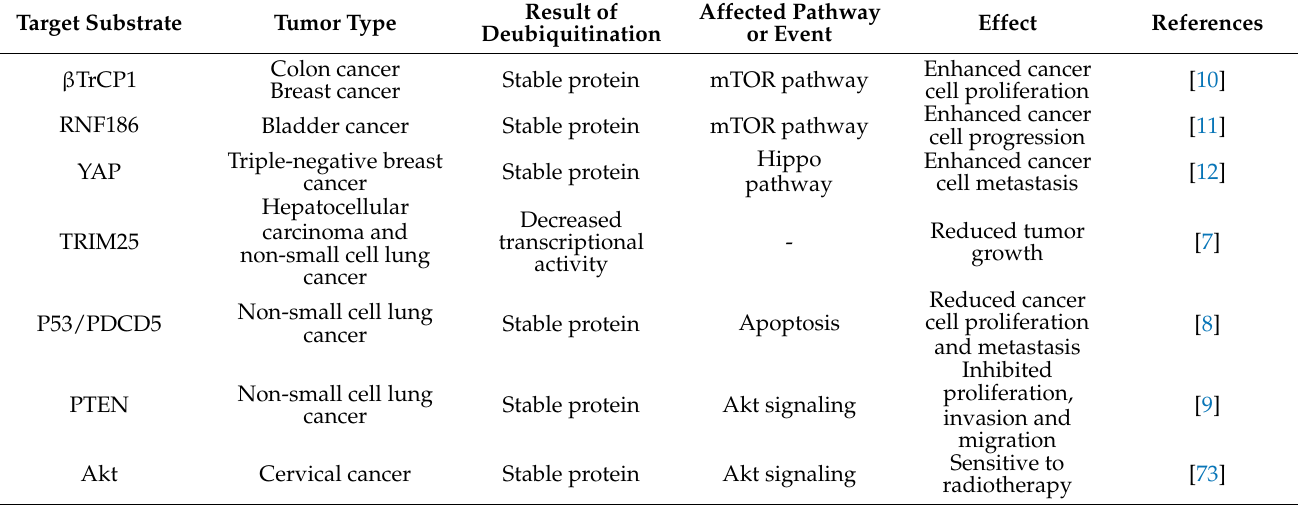
Table 1. Expression and clinical significance of OTUD5 in various